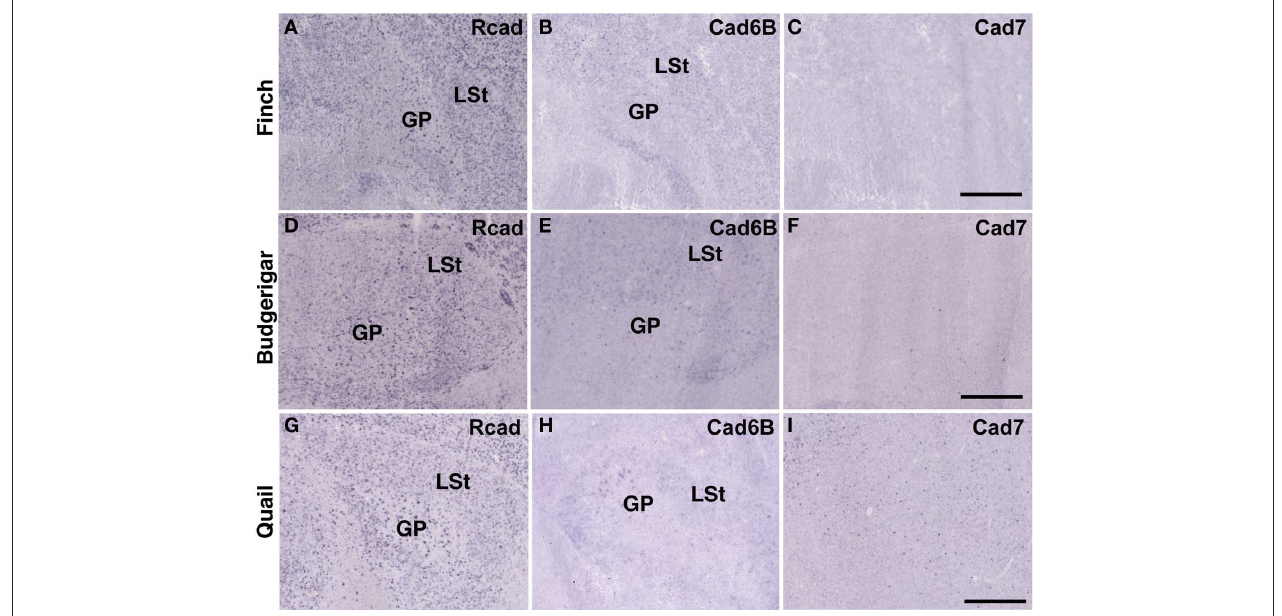
Figure 10 | Cadherin expression in the motor system of the basal ganglia. (A–i) In situ hybridization for Rcad (A,D,g) , cad6B (B,e,H) , and cad7 (C,F,i) in the Bengalese finch (A–C) , budgerigar (D–F) , and quail (g–i) . Scale bars are 1 mm.